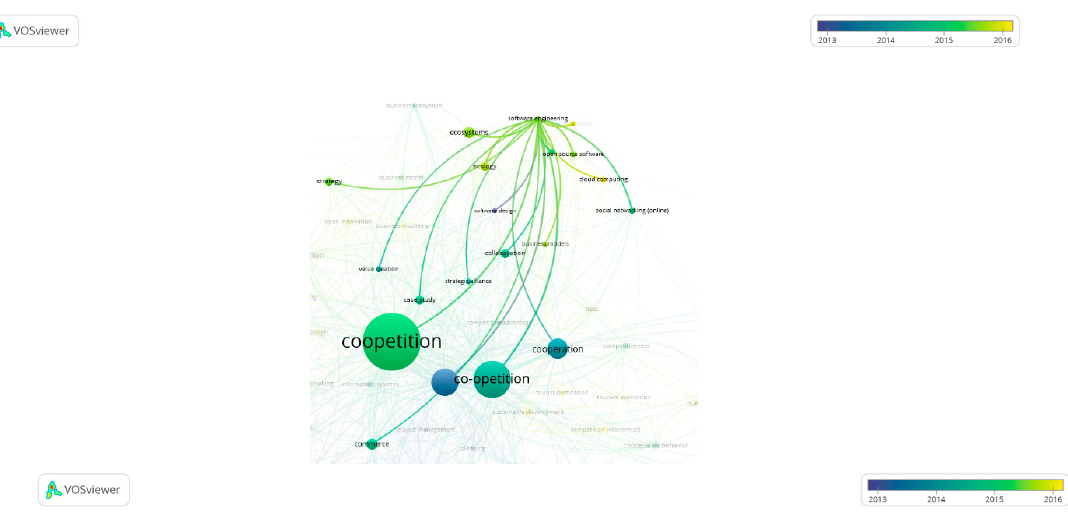
Figure 7. The fragment of overlay visualization for the term “software engineering”.